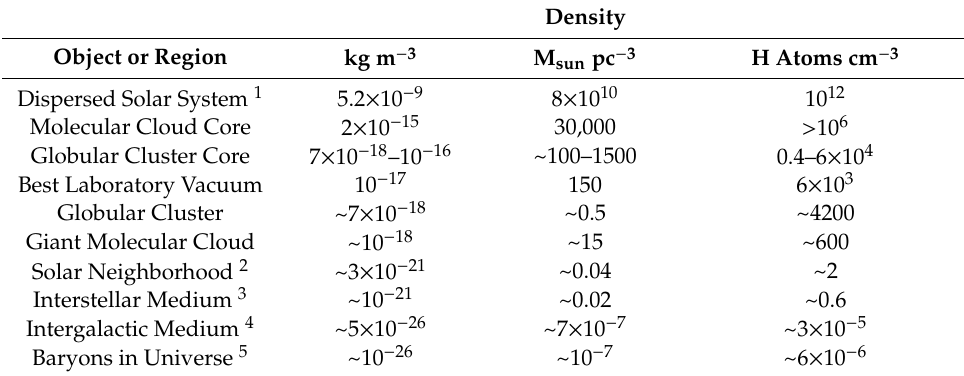
Table 1. Volumetric densities of di ff erent astrophysical environments and